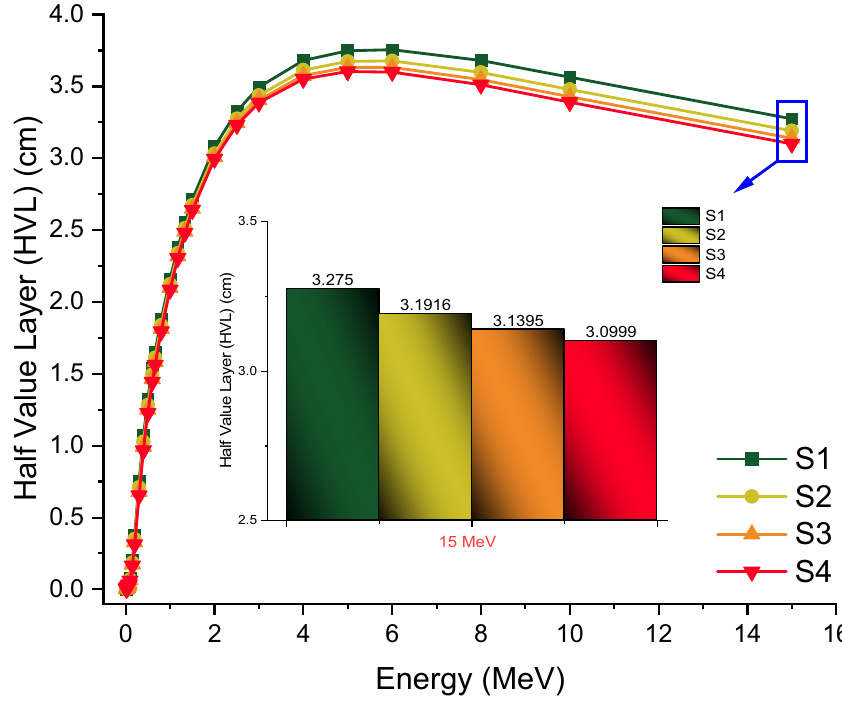
Figure 5: Variation in half value layer ( cm ) with photon energy ( MeV ) for all S1 – S4 glasses.